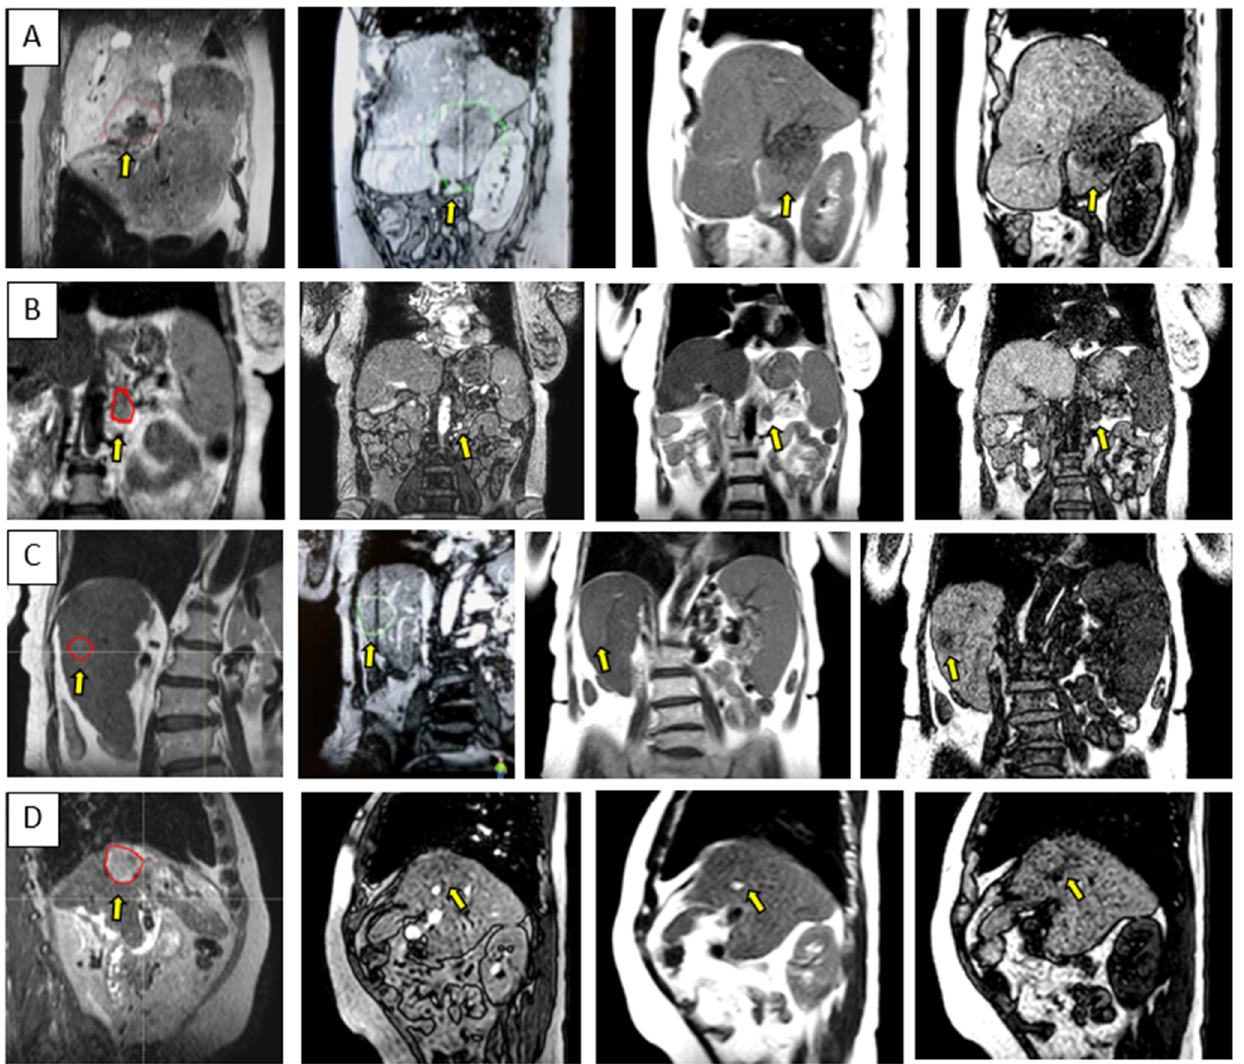
Figure 5. Sample data for four UGI patients highlighting the range of contrast available with the 3D cine sequences used for the quantification and monitoring of patient setup and target motion. Each row is for a different patient and shows either a coronal or sagittal view: ( A – D ) corresponds to Patients 10, 15, 6, and 12, as per Table 1. The columns correspond from left to right to the MR planning data set identifying the target location, btFFE cine, T2w-cine, and T1w-cine.